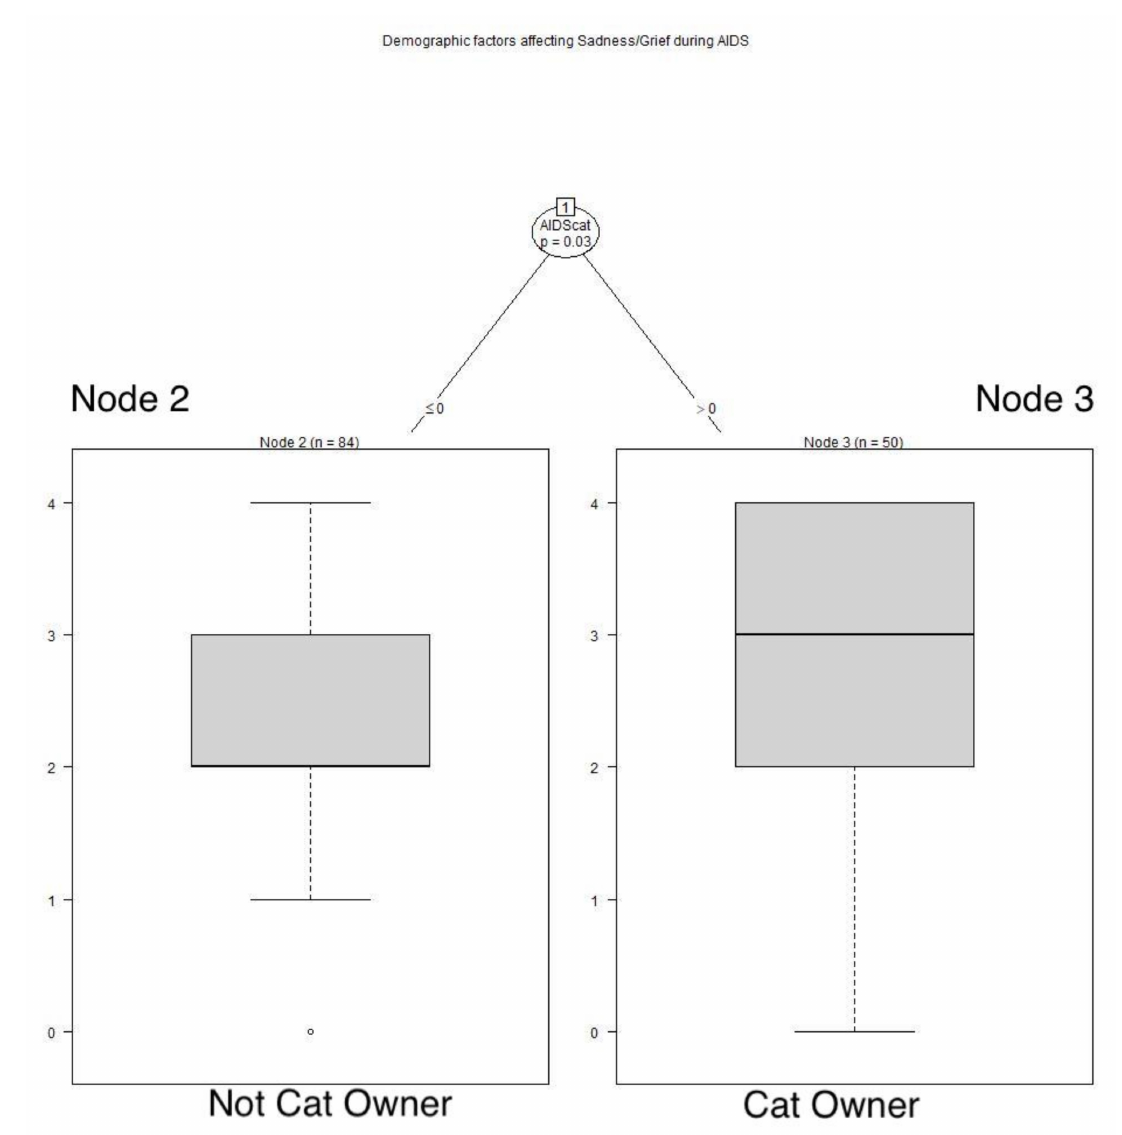
Figure 6. Demographic factors affecting sadness/grief during AIDS. Respondents who had a cat during the AIDS pandemic more often felt sadness and grief than those who did not have a cat at that time: Node 2: x − = 2.321, SD 0.9837; Node 3: x − = 2.72, SD